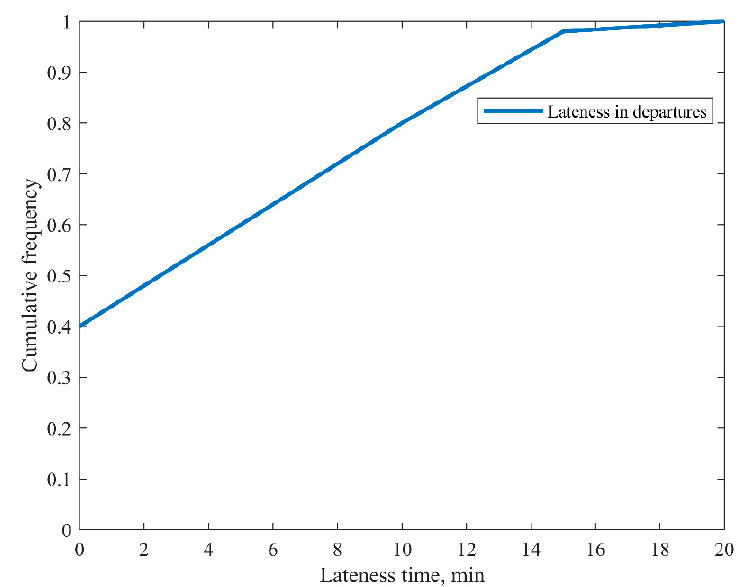
Figure A5. Departure latency distribution.